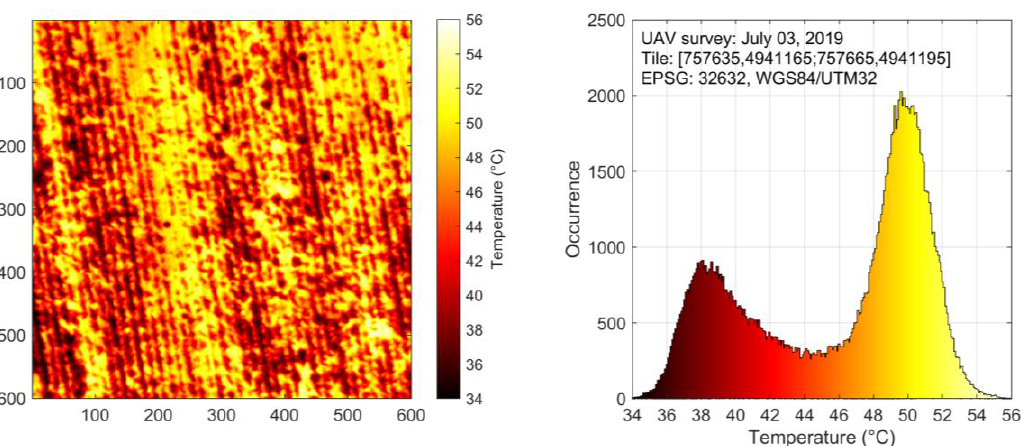
Figure 6. Image of the tile (left) and corresponding temperature distribution before calibration and after edge removal.